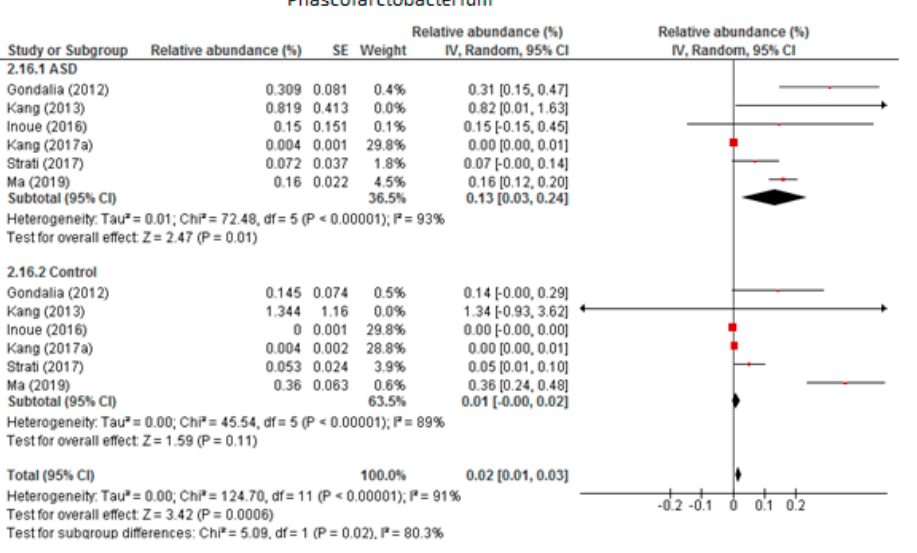
Figure 6. Forest plot of relative abundance of Phascolarctobacterium in children with ASD and controls.